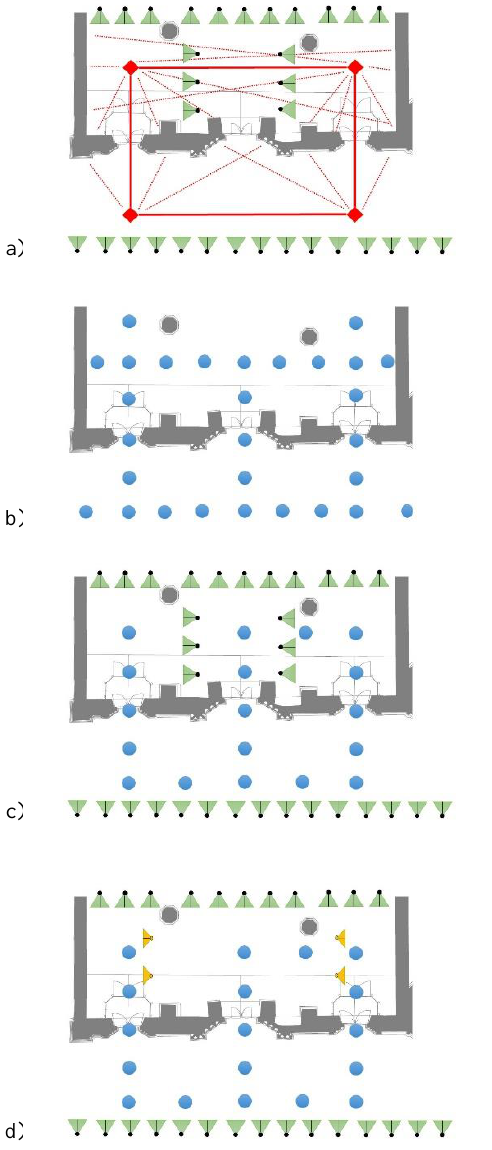
Figure 1. Some configurations for the survey of interior and exterior spaces: (a) total station (red diamonds) + central perspectives images (green triangles), (b) 360° images (circles), (c) 360° + central perspectives images, (d) 360° + central perspectives + fisheye images (yellow triangles).